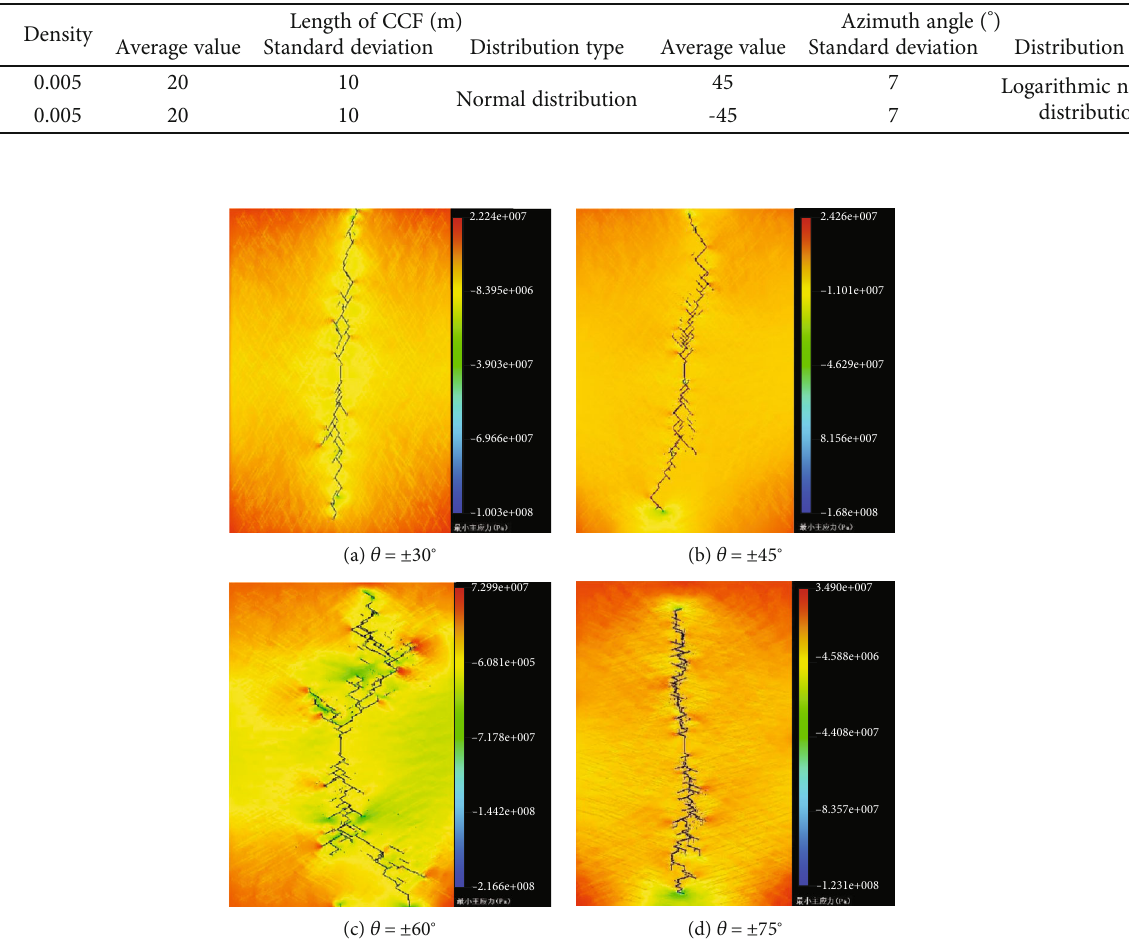
Figure 9: The propagation patterns of HFs under di ff erent fracture distribution